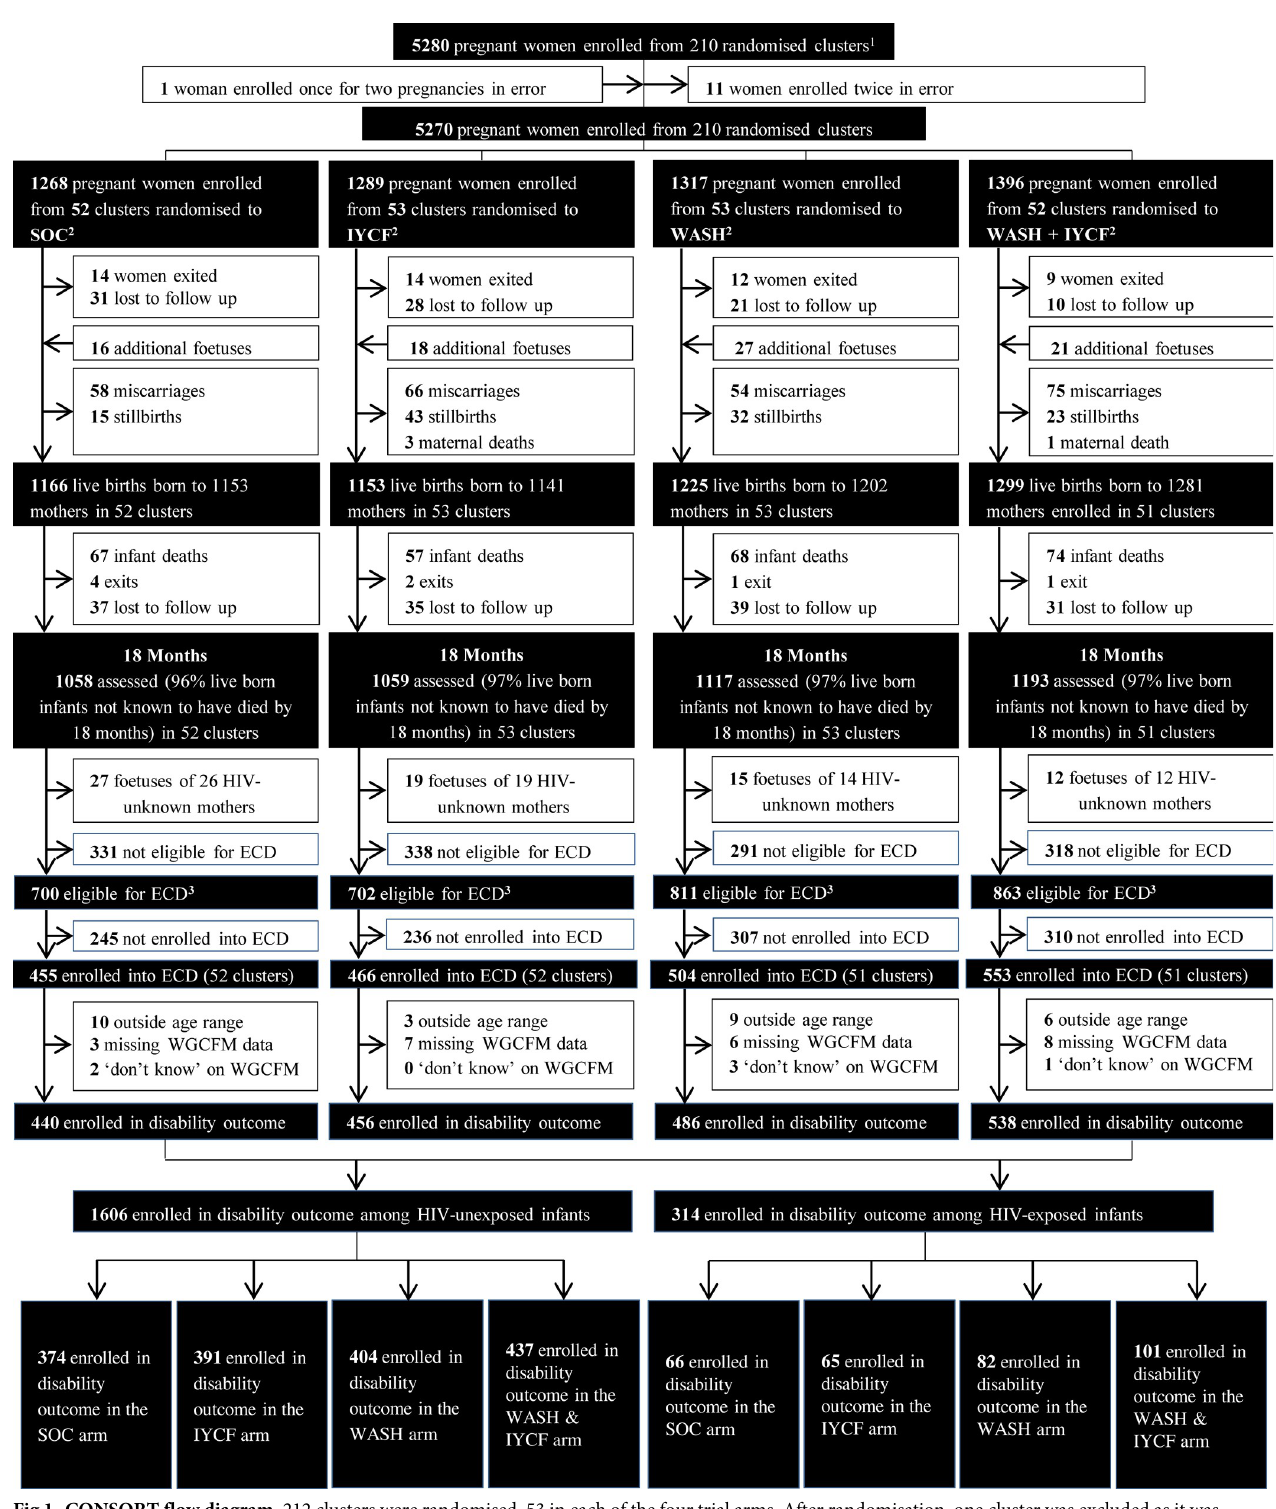
PLOS ONE | https://doi.org/10.1371/journal.pone.0274664 September 16,